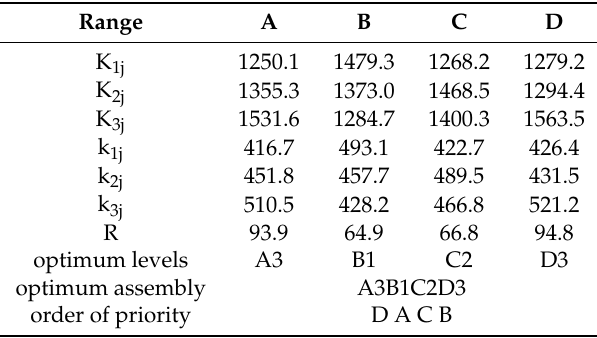
Table 6. Range analysis of elastic modulus.